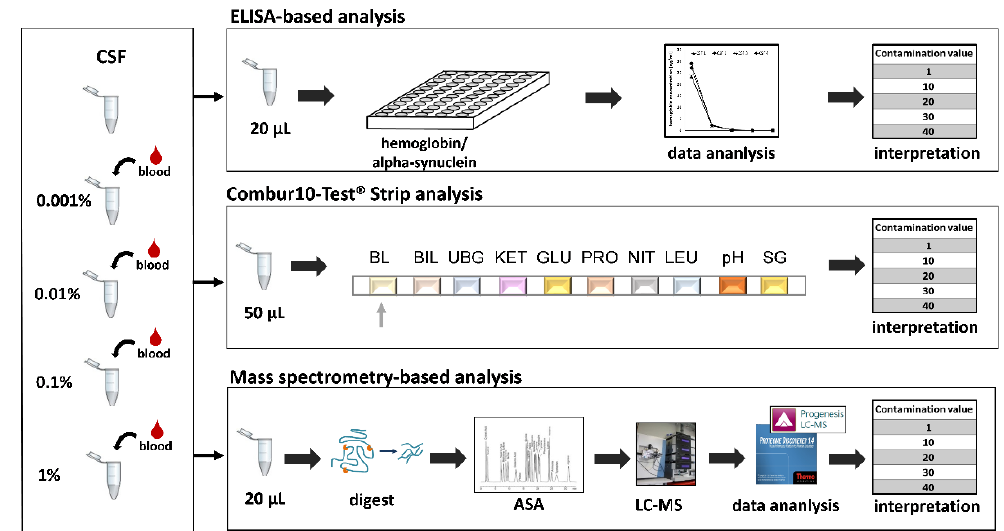
Figure 1. Overview of our study. Cerebrospinal fluid (CSF) from four different individuals was artificially spiked with four different concentrations of blood ranging from 0.001% to 1%. Those samples were subsequently analyzed using three independent methods including enzyme-linked immunosorbent assay (ELISA), Combur test strips, and MS-based bottom-up proteomics.